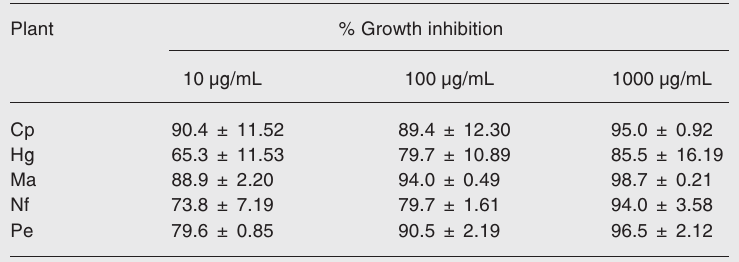
Table 2. Effect of ethanolic extrats of Cayaponia podantha (Cp), Helicteres gardneriana (Hg), Melochia arenosa (Ma), Nectandra falcifolia (Nf), and Paullinia elegans (Pe) on the growth of Trypanosoma cruzi epimastigotes. Plant